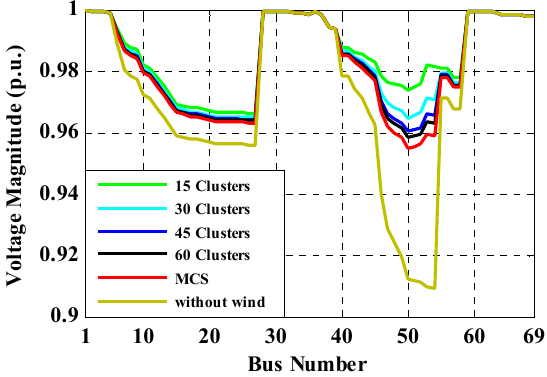
Figure 14. Voltage profile with the proposed data clustering-based direct PLF.